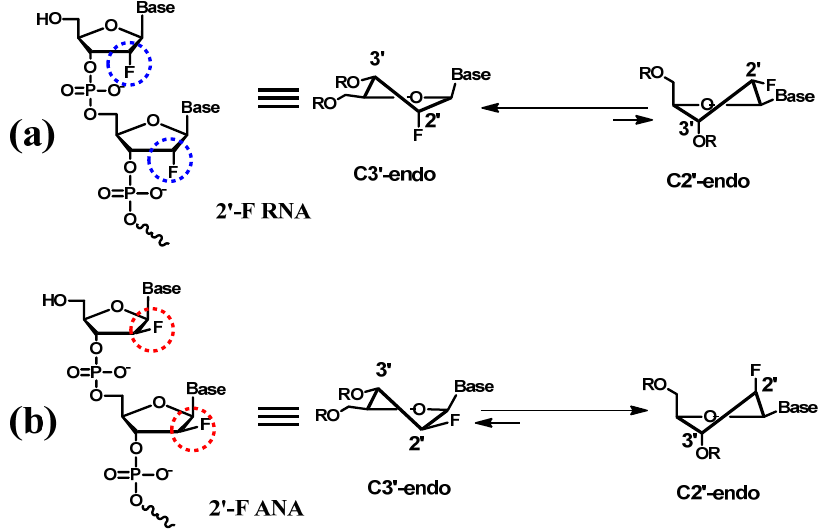
Figure 6. Structure and sugar puckering equilibrium for ( a ) 2’-deoxy-2’-fluororibonucleic acid (2’-F RNA); C3’-endo is the most stable conformation for 2’-F RNA. ( b ) 2’-deoxy-2’- fluoroarabonucleic acid (2’-F ANA); C2’-endo is the most stable conformation for 2’-F